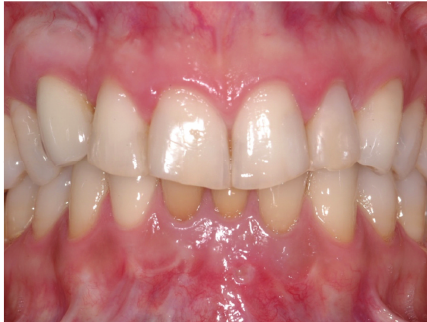
Figure 21: Three-year clinical follow-up demonstrating the volu- metric stability of the soft tissue graft and the acceptable aesthetic result compared to the contralateral side.